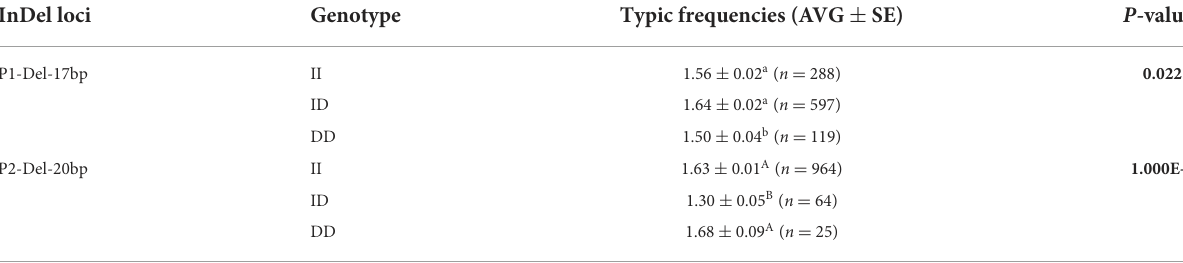
TABLE 3 Association analyses between litter size and the two InDels in SBWC goats. InDel loci Genotype Typic frequencies (AVG ± SE) P -values